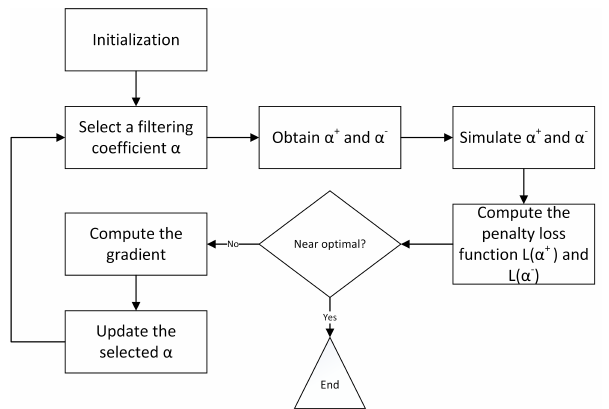
Figure 4. The optimization process of the Simultaneous Perturbation Stochastic Approximation (SPSA) algorithm.